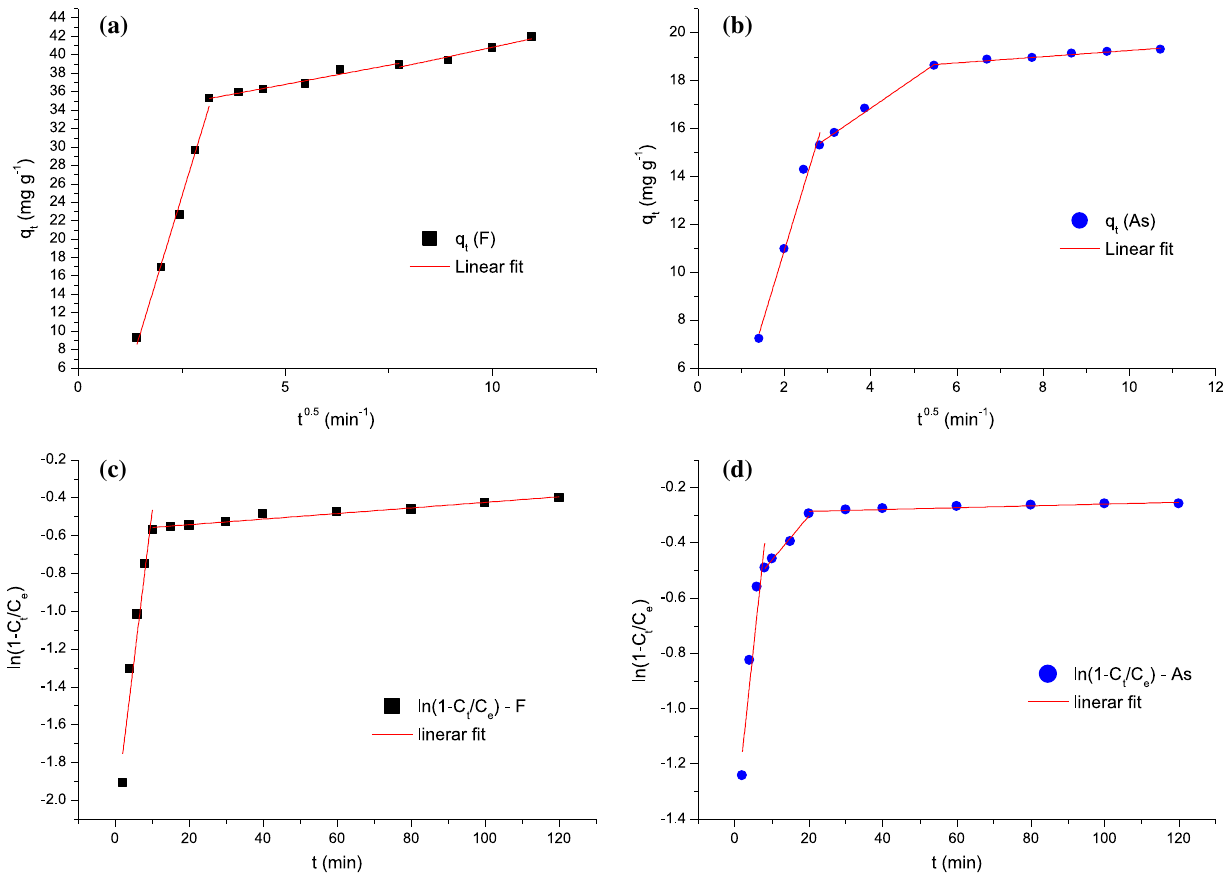
Fig. 6 Plot showing implication of diffusion models, i.e., Weber and Moris plot to fluoride ( a ) and arsenic ( b ) and Chanda plots to fluoride ( c ) and arsenic ( d